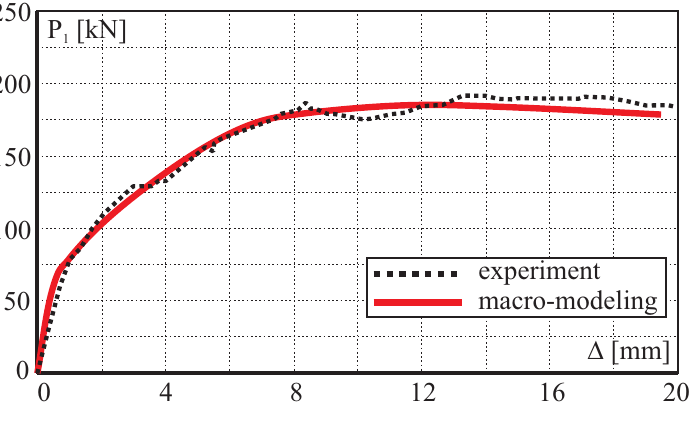
Figure 19. Comparison of load–displacement diagram.